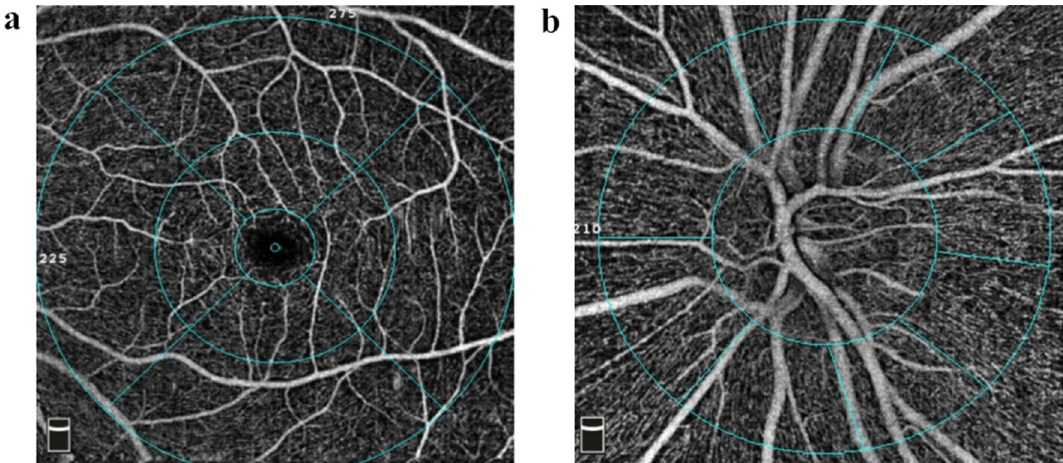
Figure 4. The AngioVue software (version 2017.1.0.155; Optovue Inc.) was a built-in software that provides a default angiography display protocol to define the stratification interval for en face vascular imaging (in this figure). ( a ) The microvessels in the macular area. ( b ) The peripapillary capillary network